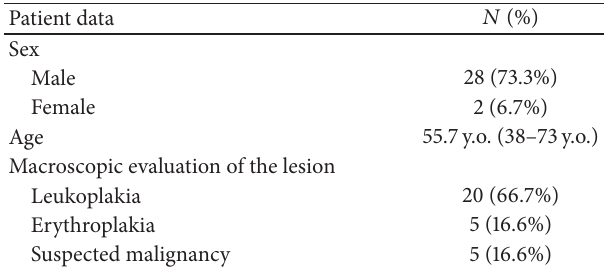
Table 1: Baseline characteristics of the patients enrolled in the